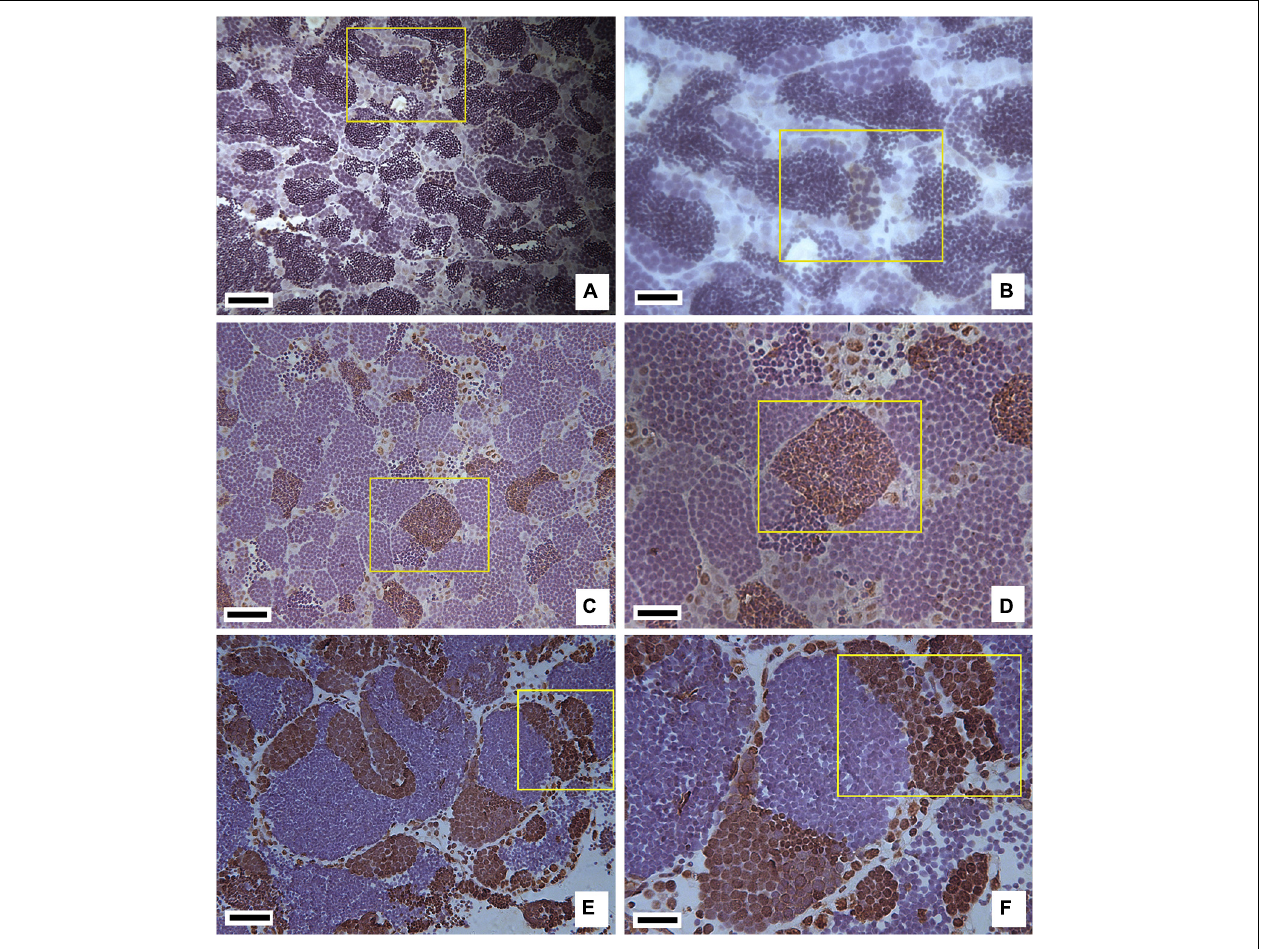
FIGURE 2 | Immunohistochemistry staining of RNA Pol II CTD P(S5) in testis tissues of RCC, 2nF 1 , and 4nAT. (A) Immunohistochemistry staining in RCC, where the positive cells are shown in the yellow box and were inferred as spermatocytes at the early prophase stage of meiosis I. (B) Enlarged view of panel (A) . (C) Immunohistochemistry staining in 2nF 1 , where the positive cells are shown in the yellow box, and some of which were spermatogonia while others were a mass of primary spermatocytes in meiotic disorder. (D) Enlarged view of panel (C) . (E) Immunohistochemistry staining in 4nAT, where RNA Pol II CTD (S5) was highly expressed in spermatogonia and some early primary spermatocytes. (F) Enlarged view of panel (E) . In panels (A,C,E) bar = 25 µ m; in panels (B,D,F) bar = 10 µ m.